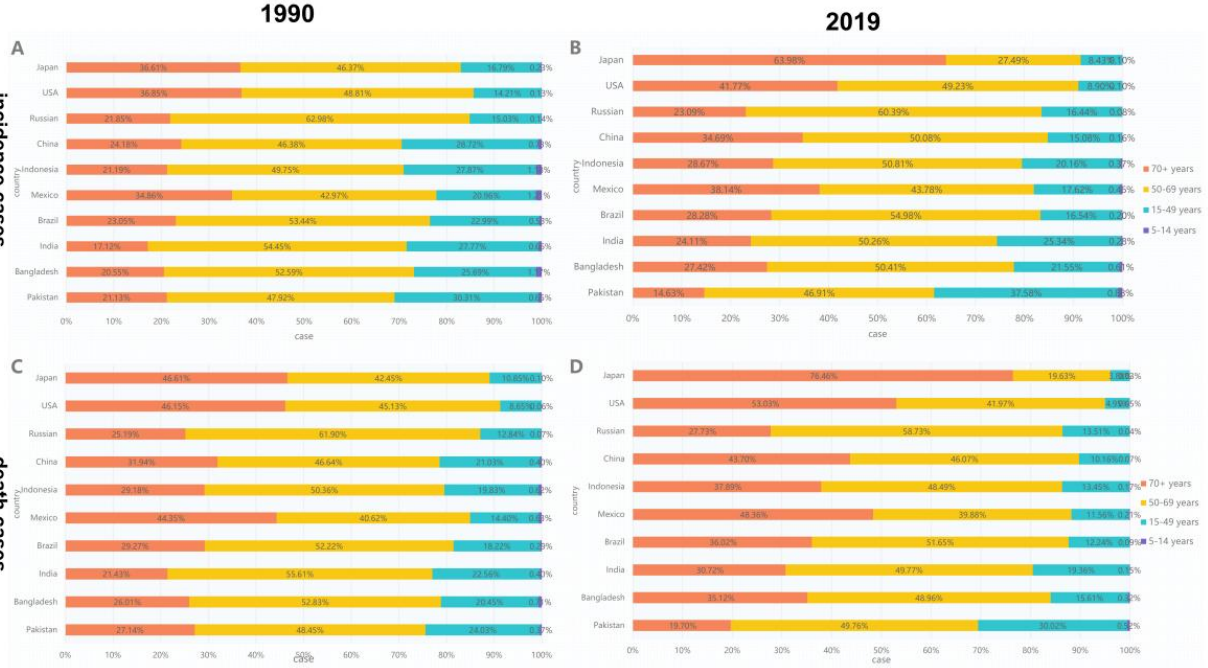
Figure 5. Distribution of different ages in oral cancer incidence/death cases by country. ( A ) Incidence in 1990. ( B ) Incidence in 2019. ( C ) Death rate in 1990. ( D ) Death rate in 2019. (Countries are ranked from highest to lowest in SDI.)